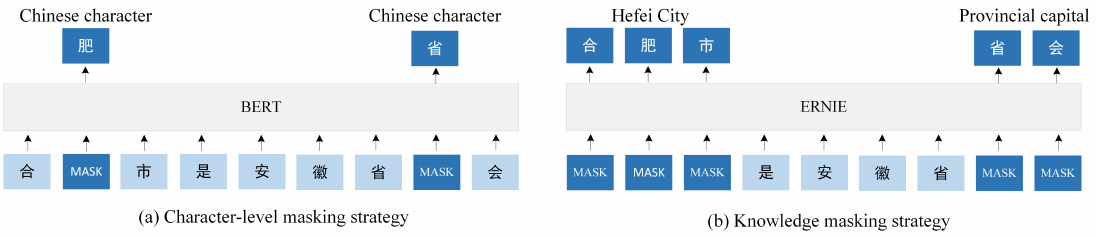
Figure 3. The different masking strategies between BERT and